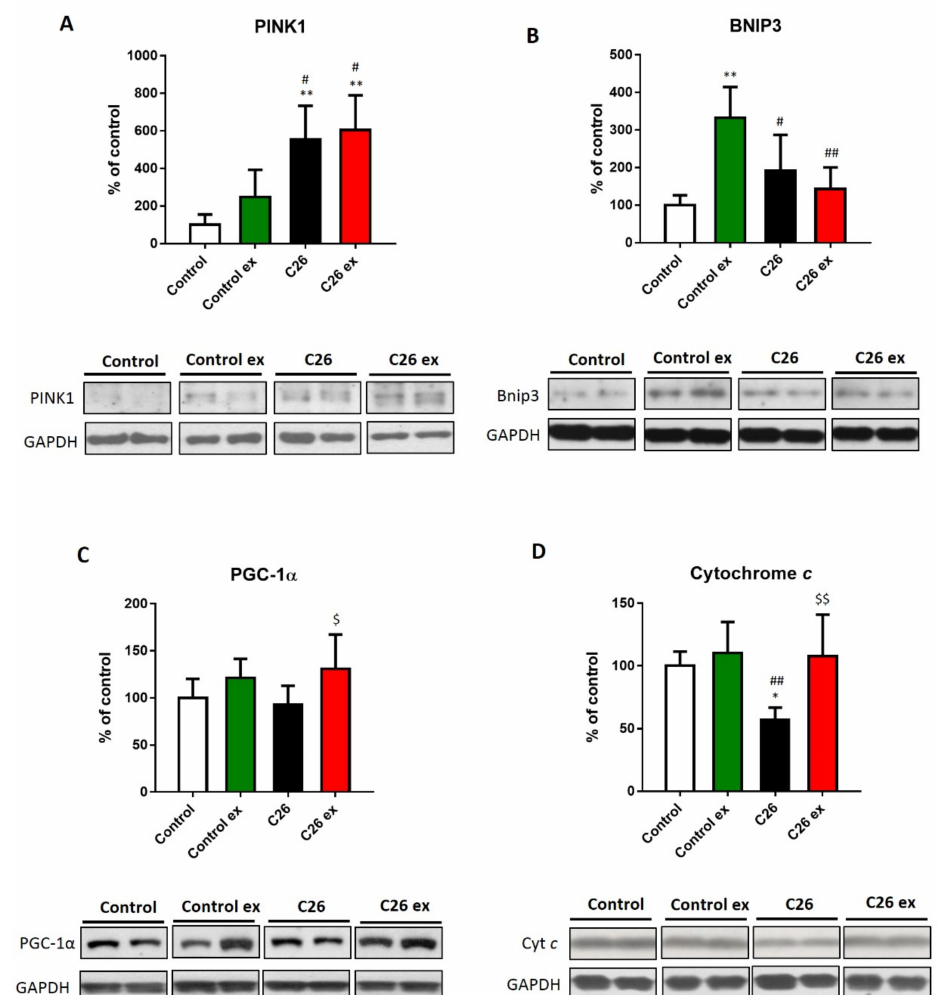
Figure 6. Exercise increases mitochondrial mass without affecting the expression of markers of mitophagy. PINK1 ( A ), BNIP3 ( B ), PGC-1 α ( C ) and cytochrome c ( D ; representative blot and quantification) protein levels of control ( n = 5), control exercised (control ex; n = 6) and tumor-bearing mice either se. dentary (C26; n = 8) or exercised (C26 ex; n = 8). Data (means ± SD) are expressed as percentage of control. Significance of the differences: * p < 0.05, ** p < 0.01 vs. control; # p < 0.05, ## p < 0.01 vs. control ex; $ p < 0.05, $$ p < 0.01 vs.